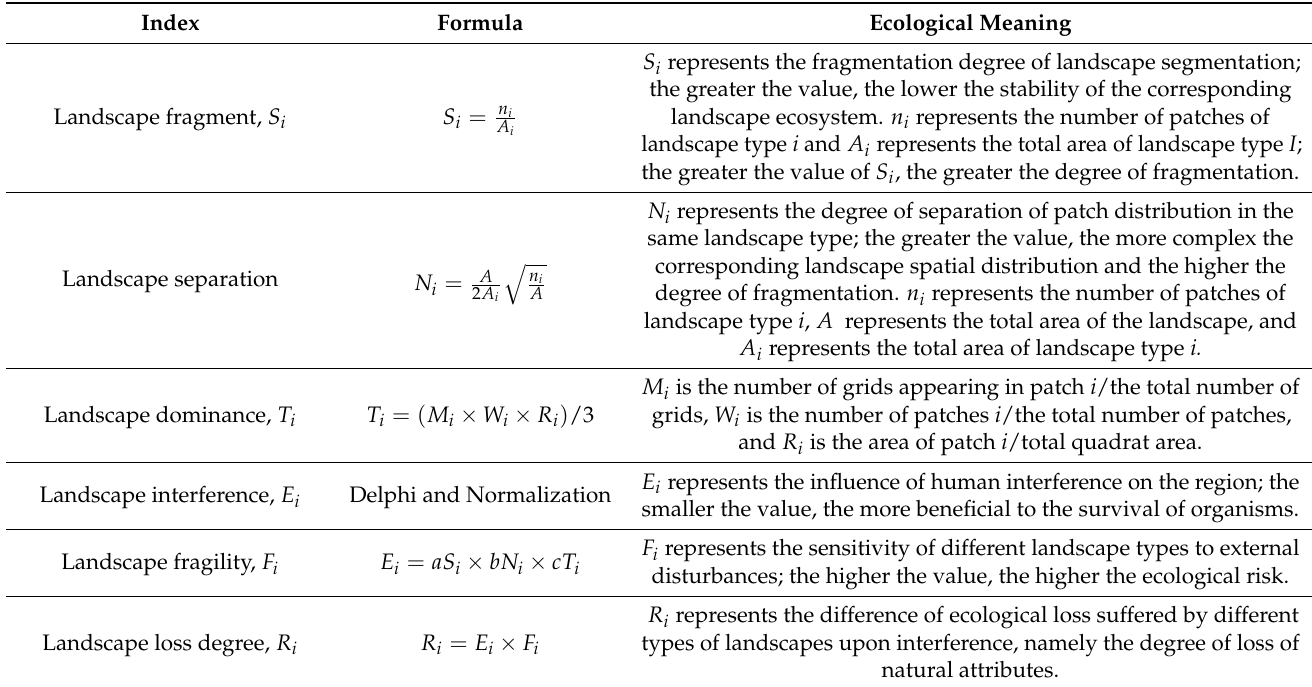
Table 1. Method for constructing the landscape pattern